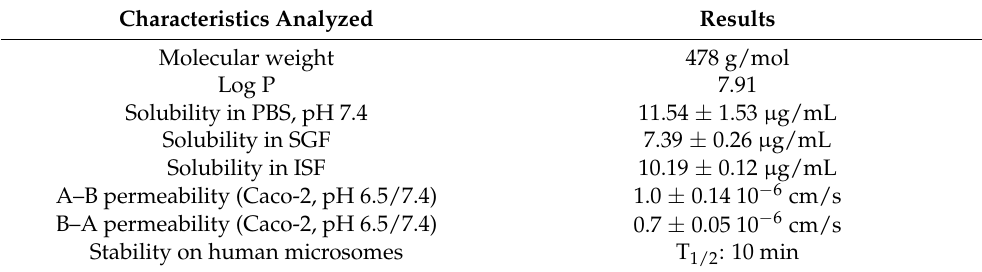
Table 2. Solubility, permeability, and stability of IP-DHA on microsomes ( n = 3). Characteristics